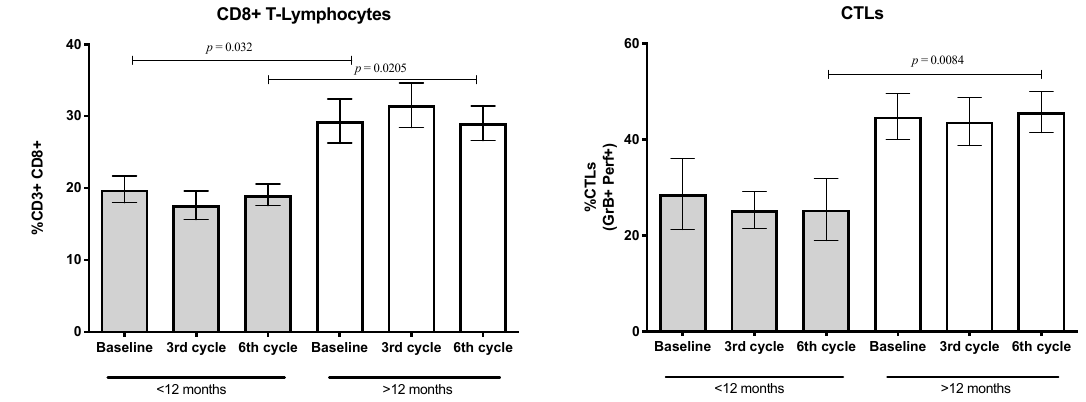
Figure 8. Percentage of CD8 + T-lymphocytes and cytotoxic T-lymphocytes (CTLs) expressing granzyme B and perforin in groups with shorter ( < 12 months, n = 11) and longer ( > 12 months, n = 19) OS. Mean ± SEM are shown.